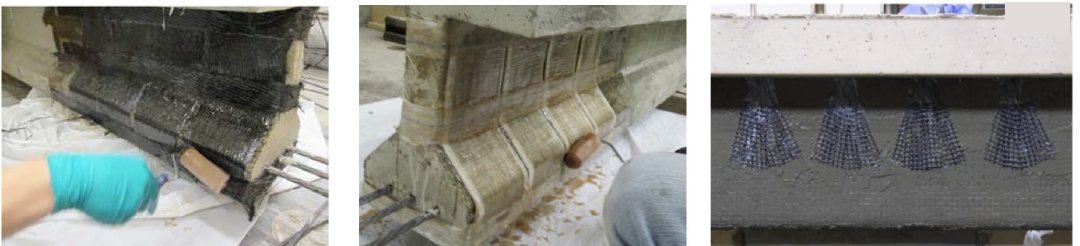
Figure 9. End anchorage system using CFRP or glass FRP (GFRP) strips [28] , and plugs of fan-shaped CFRP anchors inserted into holes inside the concrete surface [7].